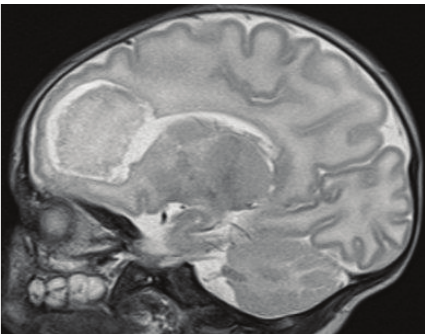
Figure 1: Cystic encephalomalacia involving the bilateral frontal periventricular white matter, reaching the left globus pallidus and caudate